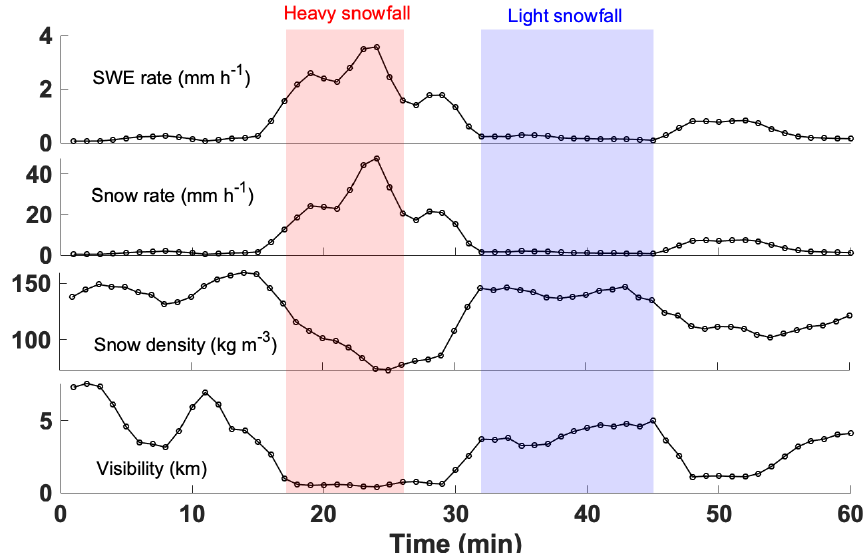
Figure 13. Time series of the 1min average of snow water equivalent (SWE), snow precipitation rate (PI snow ), mean snow density and visibility obtained at Alta-Collins on 15 April 2020.